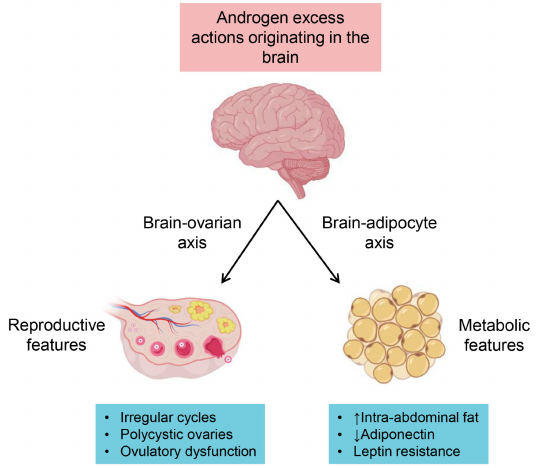
Figure 3. The most recent understanding of androgen receptor mechanisms proposed to be involved in PCOS trait development. Here we illustrate the two proposed axes involved in the development of reproductive and metabolic features of PCOS resulting from androgen excess and the consequential PCOS traits